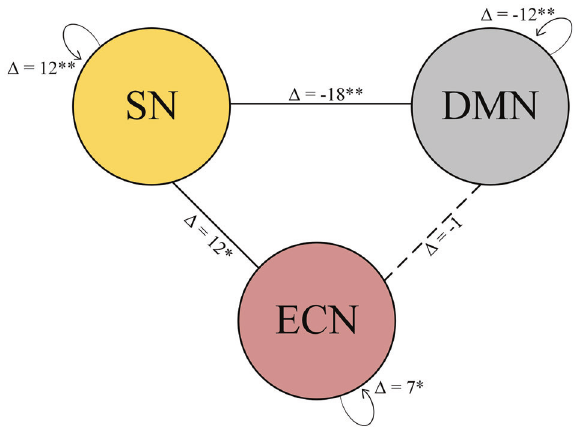
Fig. 3 Graphical representation of network-level differences in maturational coupling. Delta constitutes the difference score in the number of covariance connections between high-stress-exposed infants and low-stress-exposed infants. Positive values indicate high stress >low stress. DMN default mode network, SN salience network, ECN executive control network. * P < 0.05, ** P <